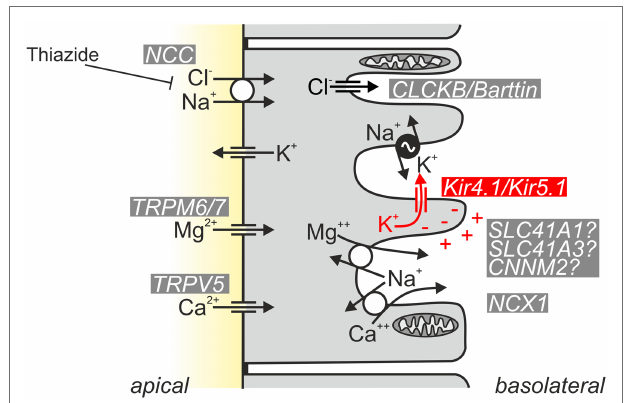
FIGURE 4 | Schematic of normal Kir4.1/Kir5.1 function in the DCT. Kir4.1/Kir5.1 heteromeric channels are localized in the basolateral membrane, which has numerous deep infoldings. There, the channel ensures that sufficient K + is available to be taken up by the Na + /K + -ATPase (pump–leak coupling). Moreover, Kir4.1/Kir5.1 channels hyperpolarize the basolateral membrane, generating the driving force for the potential-dependent export of Mg 2+ and Ca 2+ and the efflux of Cl − through CLCKB/Barttin Cl − channels. The latter has implications for cytosolic Cl − concentration and is thought to indirectly modulate NCC activity. Ca 2+ is also extruded basolaterally via Ca 2+ -ATPase (not shown). The molecular nature of the pathway for basolateral Mg 2+ extrusion is still a matter of debate; likely candidates are